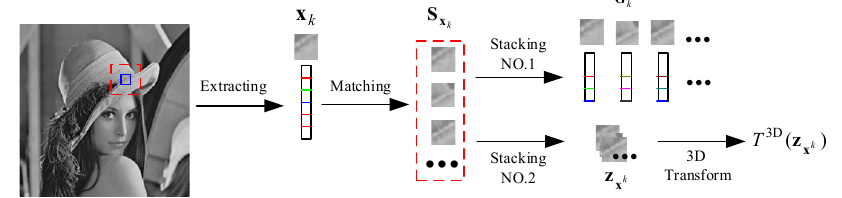
Figure 2. Construction of the similar block group and the non-local self-similar statistical model.